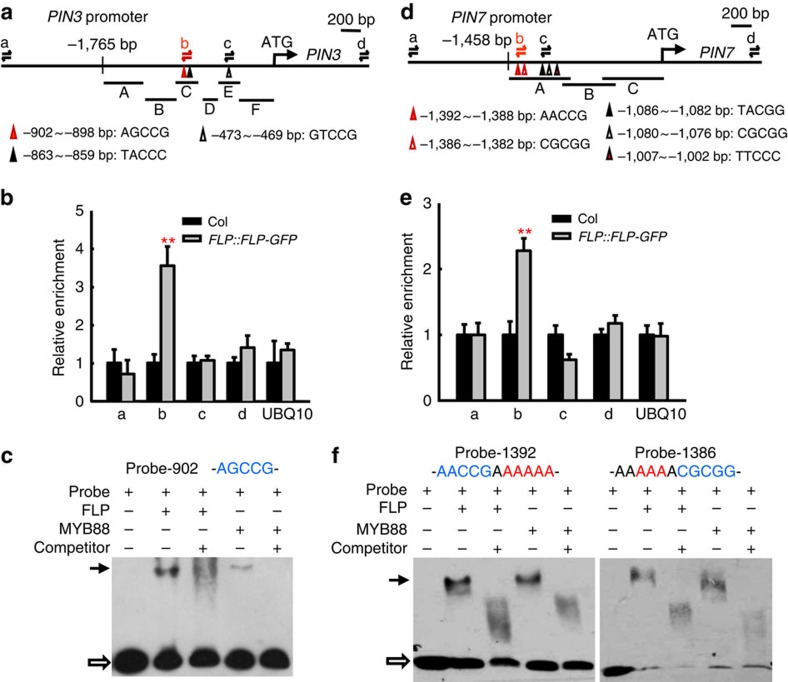
FLP and MYB88 bind directly to the promoter regions of the PIN3 and PIN7 genes.(a) Diagram showing putative FLP/MYB88-binding elements in the PIN3 promoter. Six fragments (labelled A–F) located within 1,765 bp upstream of the PIN3 translational start site were used in a yeast-one-hybrid assay (see Supplementary Fig. 4a). The three triangles indicate putative FLP/MYB88-binding elements. (b) ChIP–qPCR assays were performed using seedlings harbouring FLP::FLP-GFP and probed using anti-GFP antibodies. PCR products that are generated by primer pairs at position ‘b' shown in a, which includes element (–902)AGCCG, are enriched in FLP::FLP-GFP transgenic plants. (c) EMSA assays. A black arrow indicates the protein–DNA complexes. His-FLP or His-MYB88 proteins can form complexes with labelled Probe-902, which contains (–902)AGCCG element. Hollow arrow marks free labelled probes. Unlabelled probes were used as competitors. (d) Diagram of putative FLP/MYB88-binding elements in the PIN7 promoter. Three fragments (labelled A–C) that are localized within 1,458 bp upstream of the PIN7 gene were tested using yeast-one-hybrid assays (see Supplementary Fig. 5a). Five triangles indicate the positions of putative FLP/MYB88-binding elements. (e) ChIP–qPCR assays. PCR products that are generated by the primer pairs located at position ‘b' shown in d are enriched in FLP::FLP-GFP transgenic plants. (f) EMSA assay showing that AACCG and CGCGG (in blue letters) are FLP/MYB88-binding elements in the PIN7 promoter. Probe-1392 and Probe-1386 contain (–1392)AACCG and (–1386)CGCGG, respectively; the neighbour element was mutated (replaced with A, in red letters). The black and hollow arrows indicate the protein-DNA complexes and free probes, respectively. Asterisks in b,e indicate significant differences (Student's two-tailed t-test; **P<0.01 compared with respective Col controls; three individual experiments). Bars represent mean values with s.d.